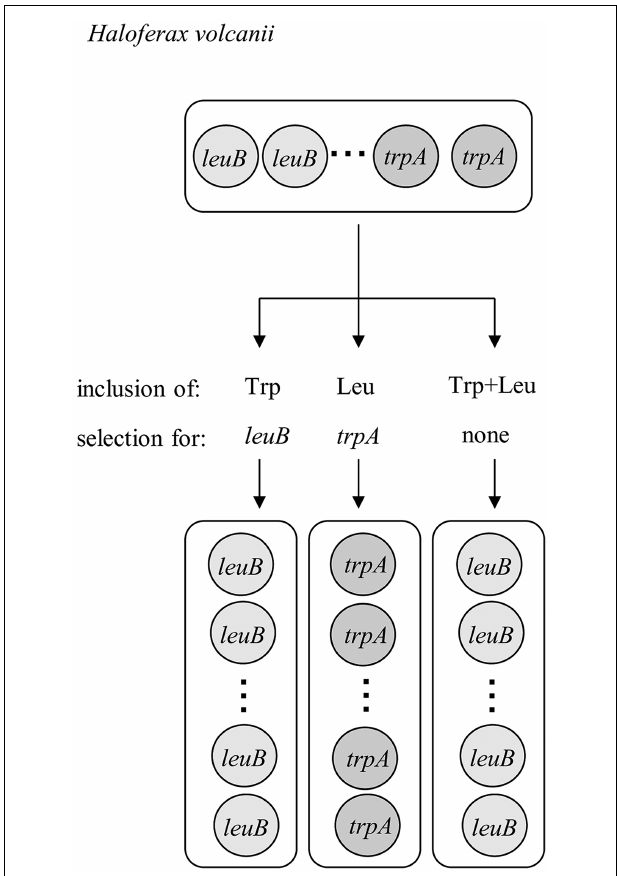
FIGURE 1 | Schematic overview of an experiment verifying that gene conversion operates in the absence of selection in Haloferax volcanii (changed version of Figure 1 in Soppa,